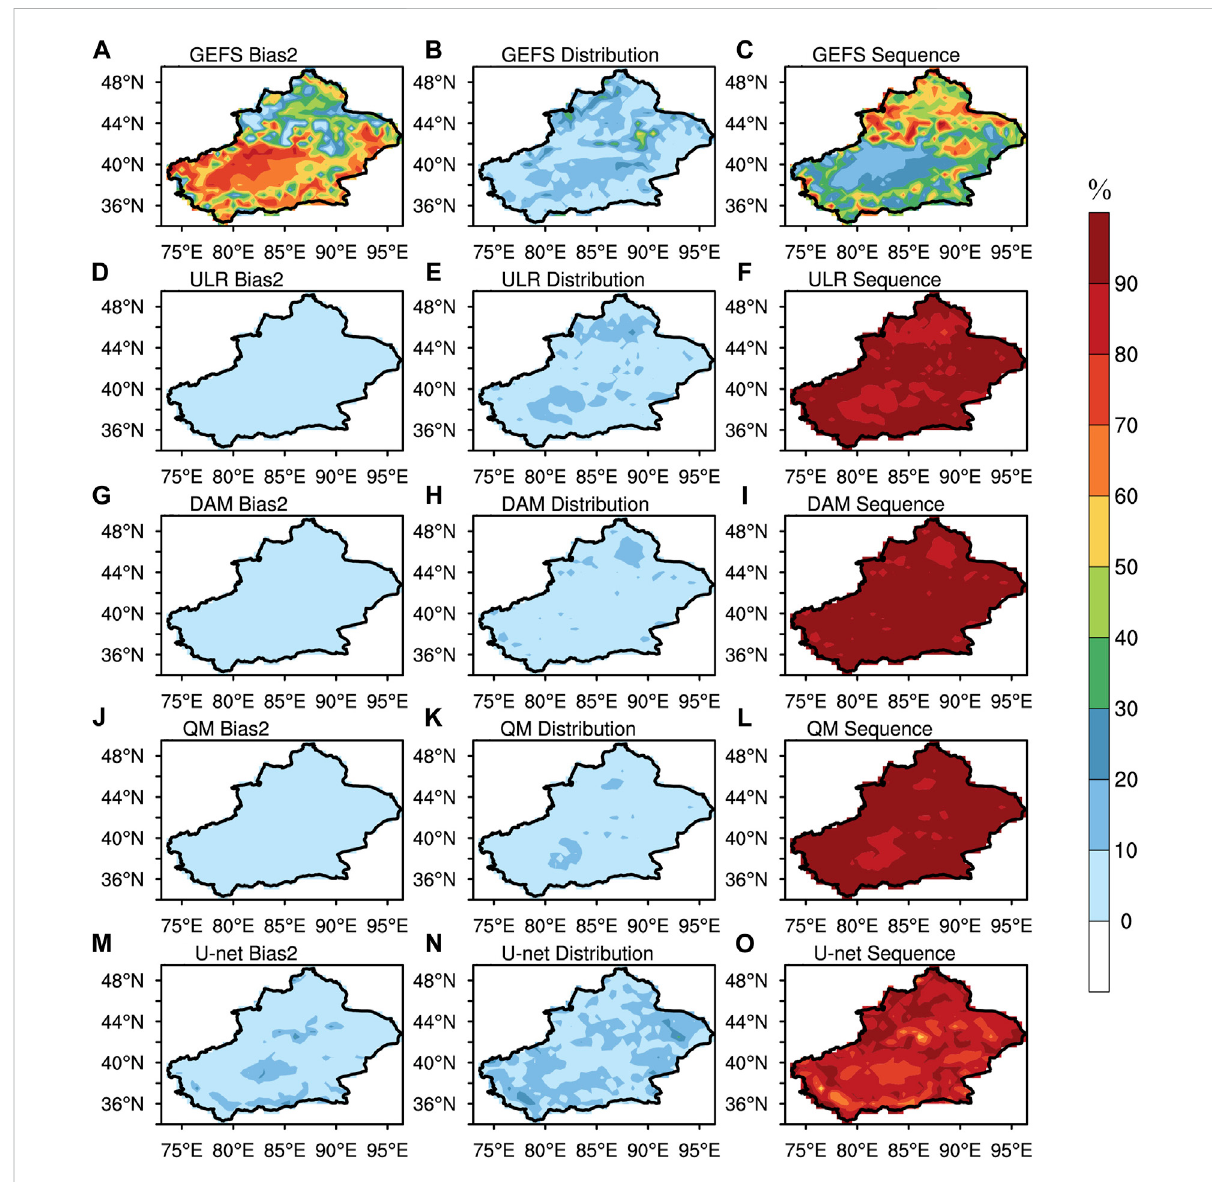
FIGURE 9 Spatial distribution of the proportion (%) of each decomposition component in the MSE at the lead time of 1 day derived from GEFS (A – C) , ULR (D – F) , the DAM (G – I) , QM (J – L) and U-net (M – O)